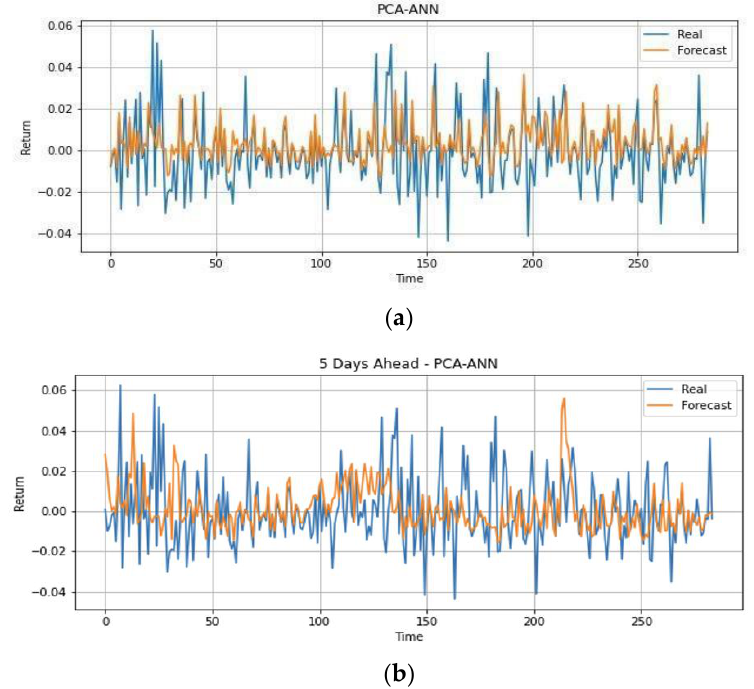
Figure 8. PCA-ANN Forecasting Result for One-Day- ( a ) and Five-Day-Ahead ( b ).